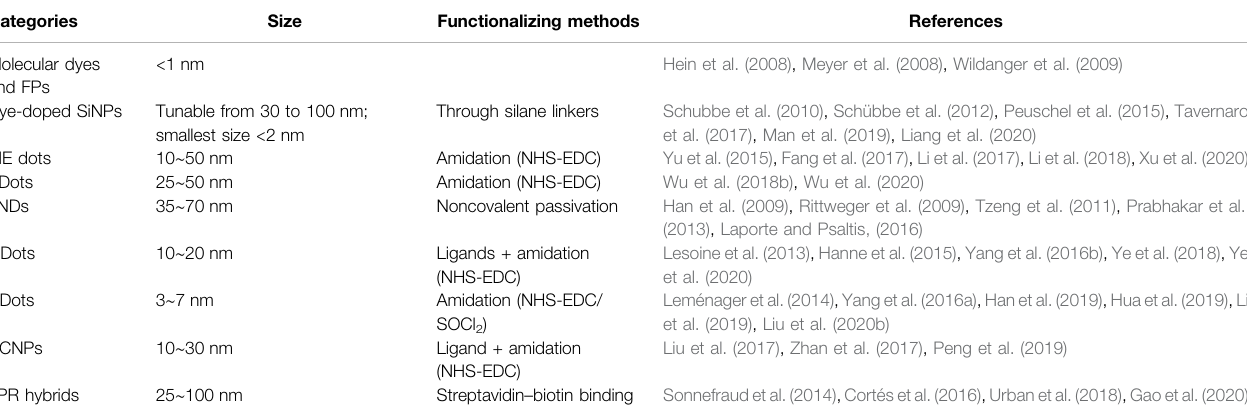
TABLE 1 | Summary of the particle sizes and surface functionalizing methods for STED